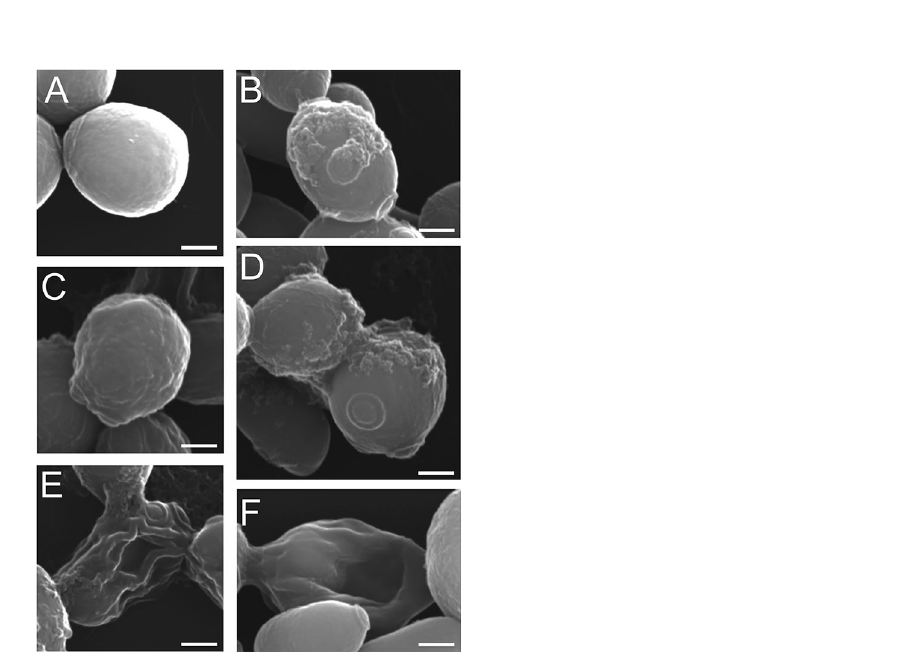
Figure 6. SEM images of: ( A ) C. albicans control cell, ( B – F ) C. albicans cells after incubation with AAF (100 µg mL −1 ). Images ( B , C , D ) cells with an irregular and rough surface; images ( E , F ) show collapsed cells. Bars represent 2